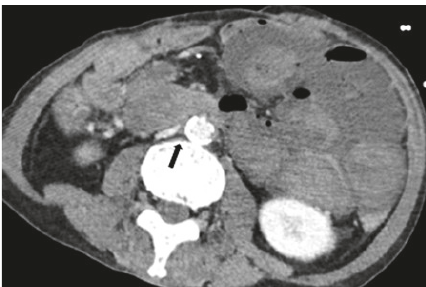
Figure 1: Contrast-enhanced computed tomography image on admission.Amassivehematomaisvisibleinthesmallintestine,with mucosal thickening of the duodenal wall, duodenal stenosis at the level of the third and fourth portions of the duodenum, and soft- tissuedensity(arrow)withfatstrandingbetweentheduodenumand